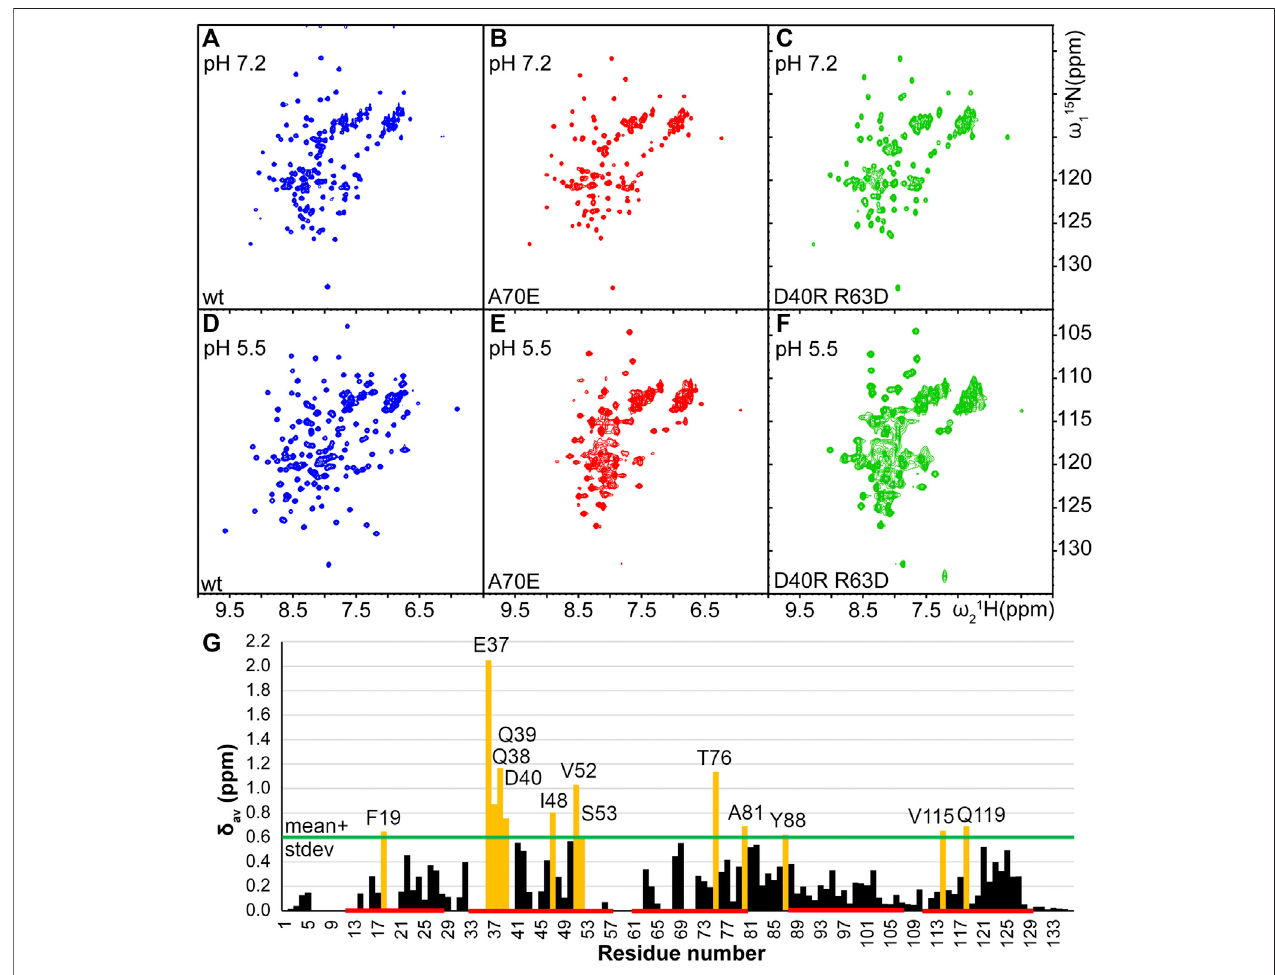
FIGURE 2 | Comparison of 15 N- 1 H HSQC spectra of TuSp NT (blue, A and D ) and its potential monomeric mutants TuSp NT A70E (red, B and E ), and TuSp NT D40RR63D (green, C and F ) in 300 mM NaCl, 20 mM NaPi, pH 7.2 and 20 mM NaCl, 20 mM NaOAc, pH 5.5 respectively. (G) Averaged backbone amide 15 N and 1 H chemical shift differences